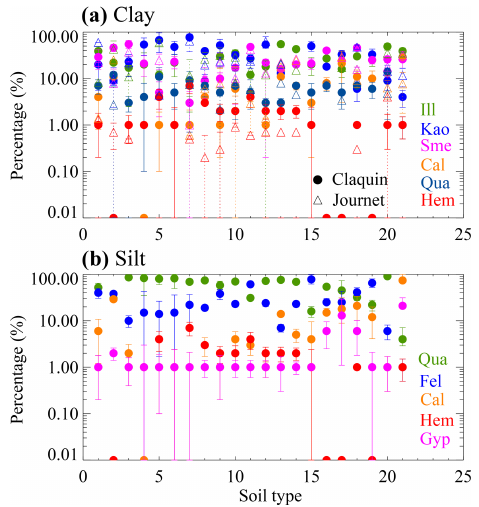
Figure 2. Mean mineral percentage (C1999: colored filled dots; J2014: colored triangle) and associated uncertainty (error bars) in the clay- (a) and silt-sized (b) categories based on C1999 and J2014 for each soil type. x -axis labels from 1 to 21 corresponds to the first column of Table 2 of Claquin et al. (1999) from top to bottom. Soil units used for comparison to C1999 data are listed in Table 3 of Journet et al. (2014) and are reordered here according to x -axis la- bels used for C1999 soil